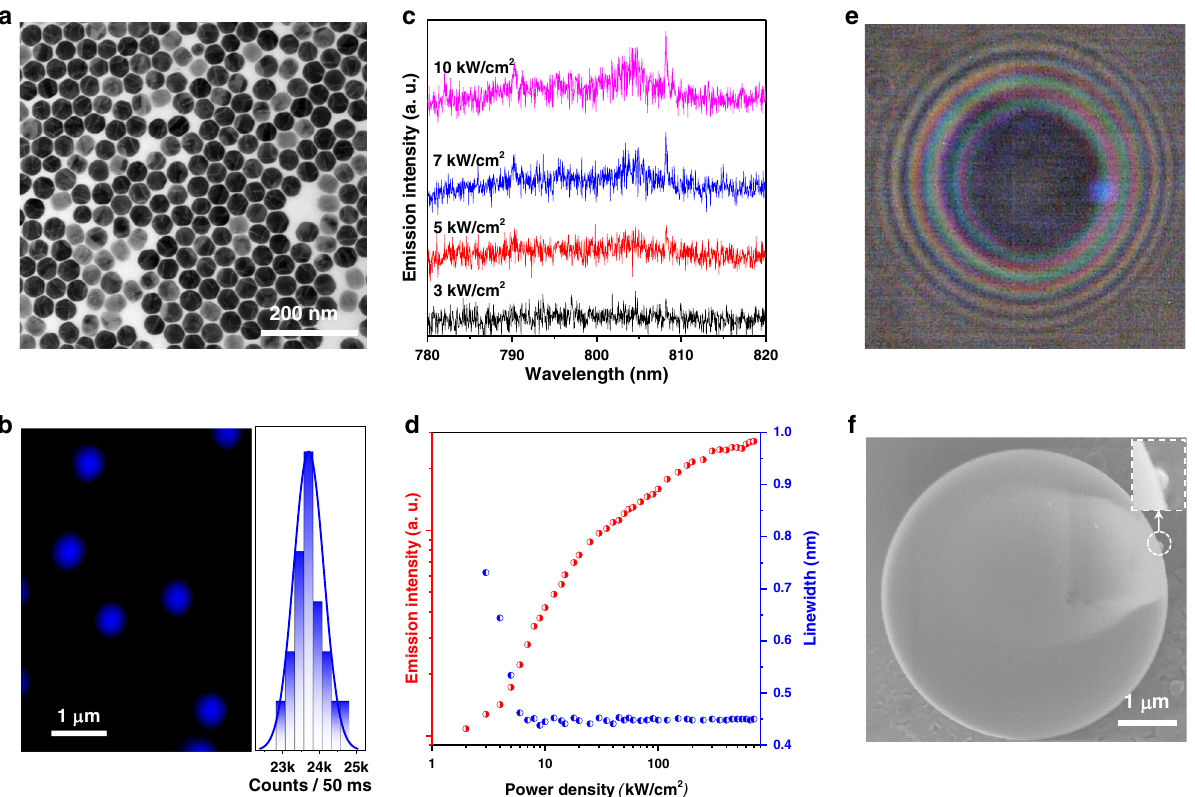
Fig. 5 Lasing emissions from a single nanocrystal. a TEM image of 43 nm monodispersed NaYF 4 :20%Yb 3 + ,2%Tm 3 + nanocrystals. b Point-scanning confocal microscopic image of single UCNPs (in pseudocolour) and their brightness distribution at an excitation power density of 100 kW/cm 2 . c Power dependent upconversion emission spectra showing the gradual appearance of lasing emission peaks at 808 nm. d The pumping power-dependent plots of emission intensities and spectral linewidth narrowing (peak@808 nm), showing the onset of single UCNP ’ s lasing emissions. e , f Wide fi eld image ( d ) and SEM image ( e ) of a single UCNP in a micro